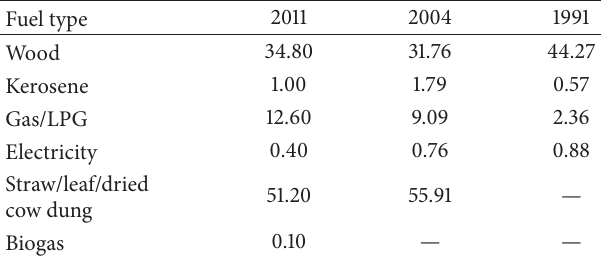
Table 1: Source of cooking fuels (in %).